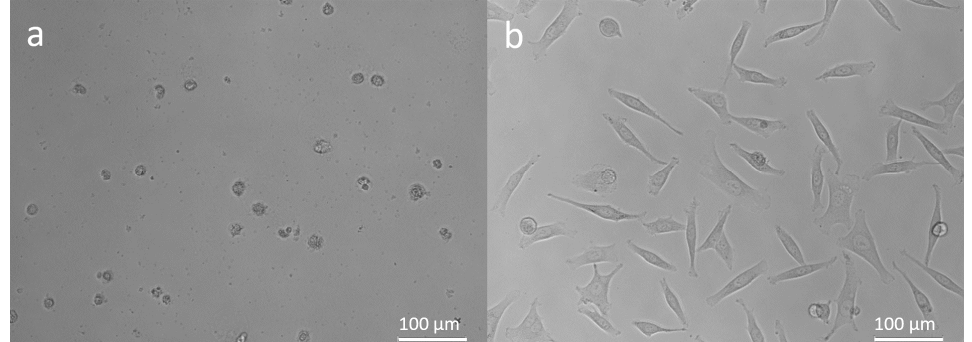
Figure 2. Morphology of WM-266-4 cells exposed to 1.00 µg/mL hemp-ginger extract ( a ) and control group: WM-266-4 cells in growth medium ( b ). Magnification 200×.